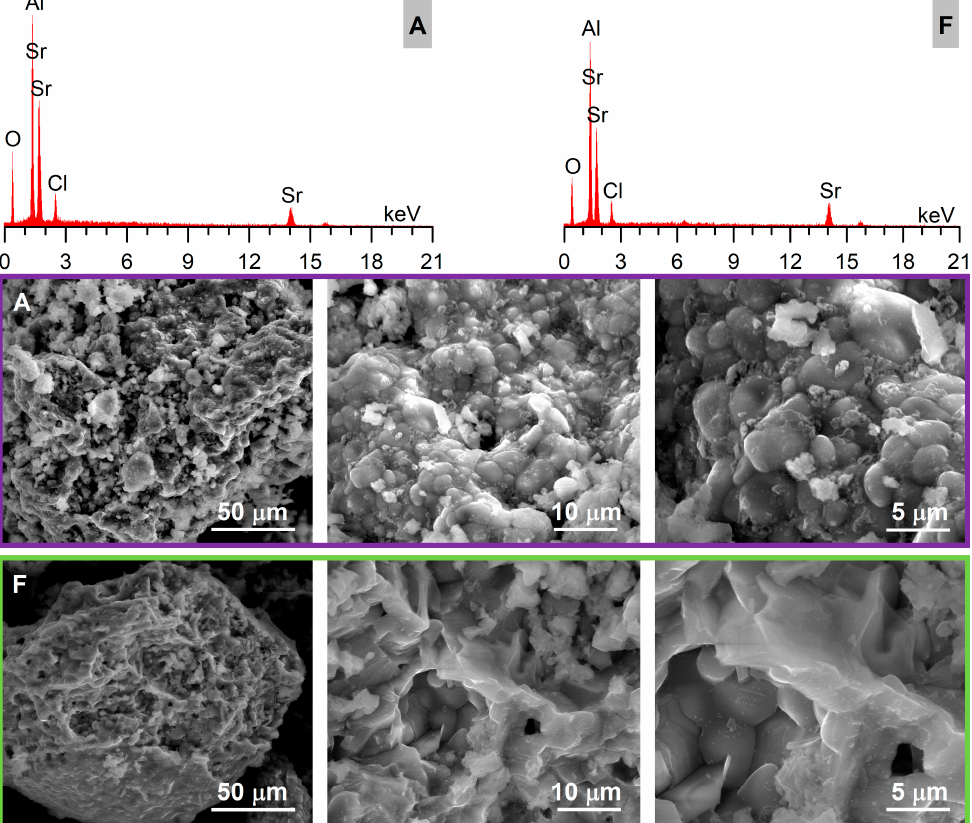
Figure 11. EDX and SEM images of samples A and F. Based on the photoluminescence measurements, sample F, which exhibited the high- est emission, was selected for testing in a coating application onto various black/white opacity charts and aluminum sheets. The F pigment was dispersed in an epoxy bi-com- ponent transparent resin in different ratios (10, 20, and 33% weight pigment). The pre- pared coatings were applied in different thickness, using block applicators with 300 and 600 µm gaps. The results are shown in Figure 12.